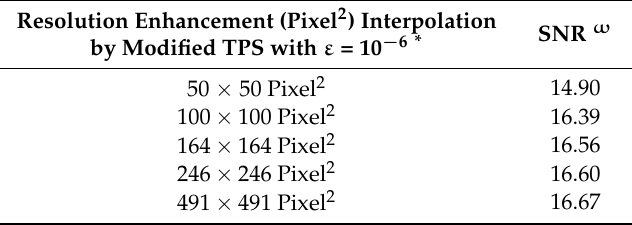
Table 3. SNR relative to interpolation size in a modified TPS method.